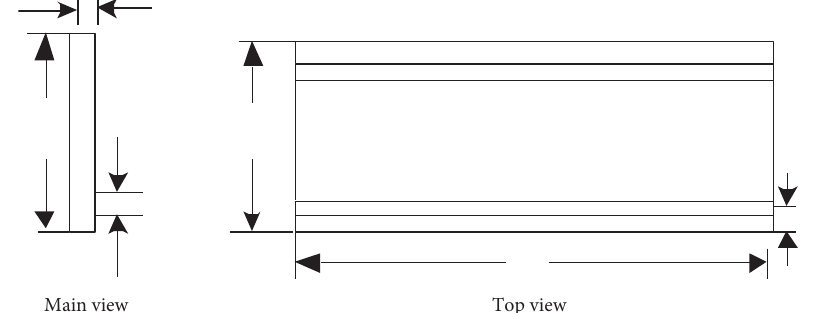
Figure 1: Double-dimensional ecological cultivation pattern of greenhouse horticulture fruit